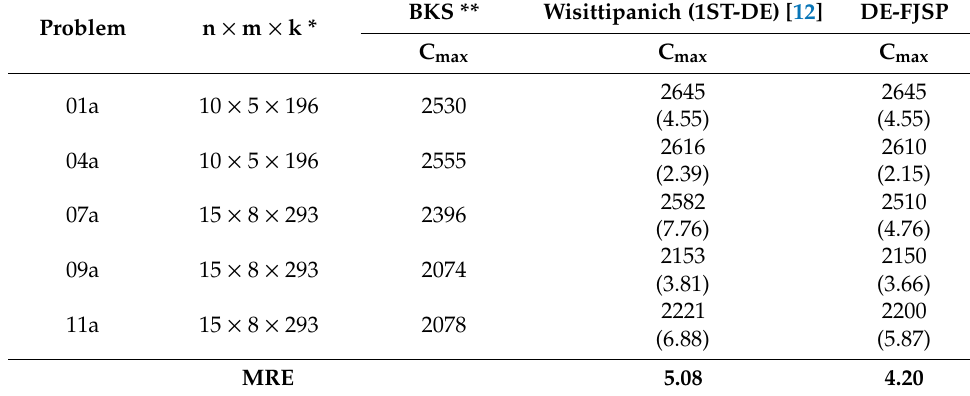
Table 18. Summary of comparing the differential evolution algorithm with other metaheuristic algorithms.